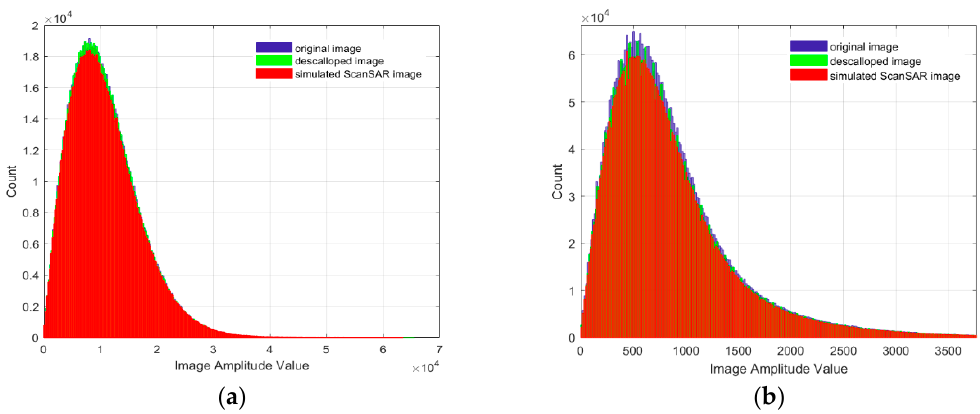
Figure 13. Histogram before and after descalloping: ( a ) uniform sea surface; ( b ) non-uniform sea surface.